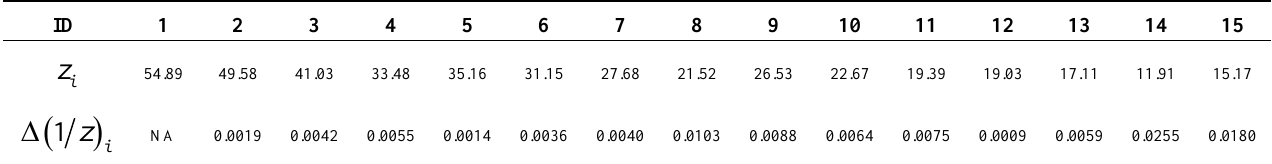
Table 1. The concentration measurements at the locations with equal spacing 20 d   cm on the centerline of the plume caused by the source to be located.